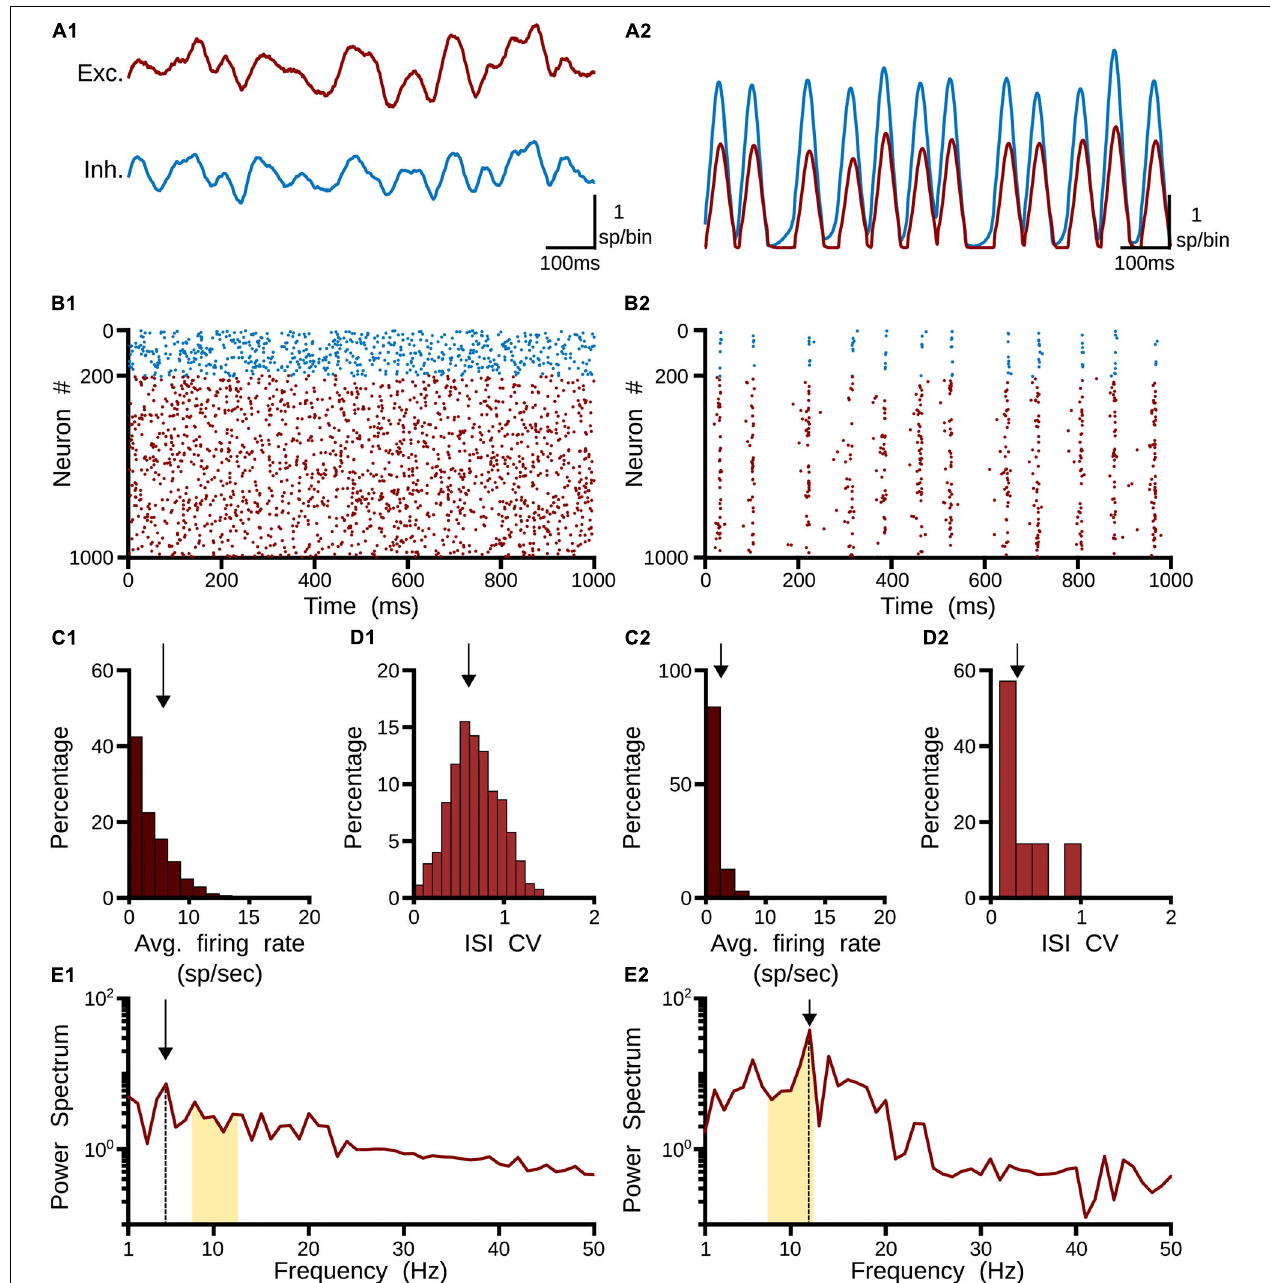
FIGURE 3 | Two responses of the pulvinar network: (1) asynchronous and (2) synchronous states. (A) PSTH (sp/bin) of excitatory (red line) and inhibitory (blue line) neurons when a spike train with Poisson’s statistics of 10 sp/s is applied to the network, (B) Raster plot for excitatory (red) and inhibitory (blue) neurons. Only 1,000 cells are shown. (C) Distribution of average firing rate (sp/s). Arrows indicate the mean of the distribution. (D) Interspike intervals (ISI) of the coefficient of variation (CV). Arrows indicate the mean of the distribution. (E) Power spectrum of PSTHs. Arrows show the maximum frequency amplitude. Yellow zones characterize alpha-band oscillation